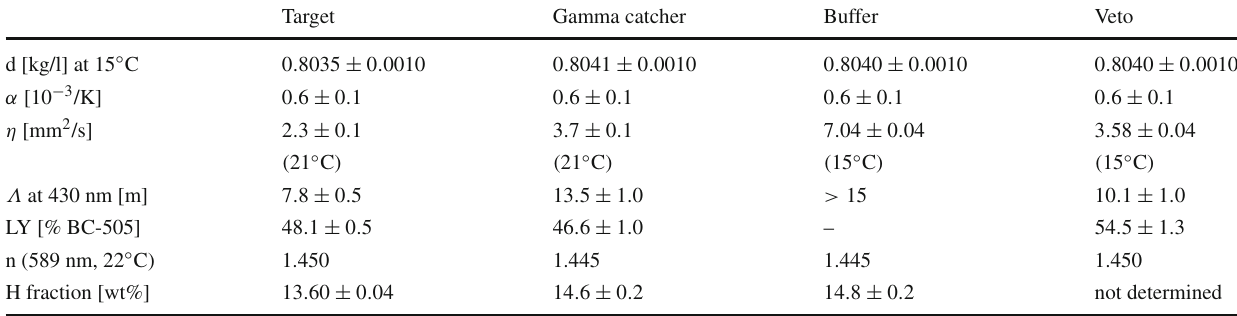
Table 2 Main properties of the liquids used in Double Chooz: density (d), thermal expansion coefficient ( α ), kinematic viscosity ( η ), attenu- ation length ( Λ ), light yield (LY), refractive index (n) and H fraction.